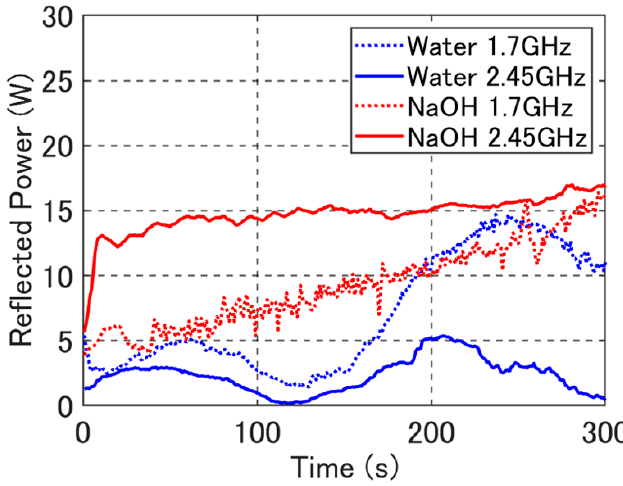
Figure 10. Reflected power of the developed cylindrical applicator during microwave heating.